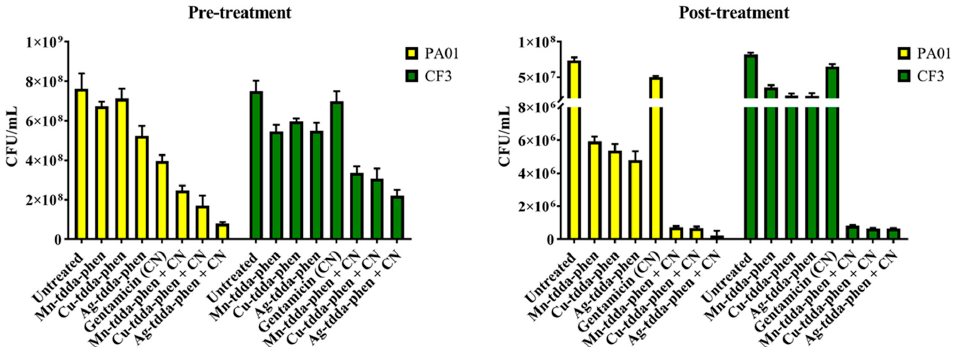
Figure 5. Viable cells were measured after pre- and post- exposure to 0.5 × MBIC and 0.5 × MBEC of metal-tdda-phen complexes alone, gentamicin alone, and metal-tdda-phen complexes with gentamicin. The results are the means ± standard errors of the means from three independent experiments, with viable counts done in